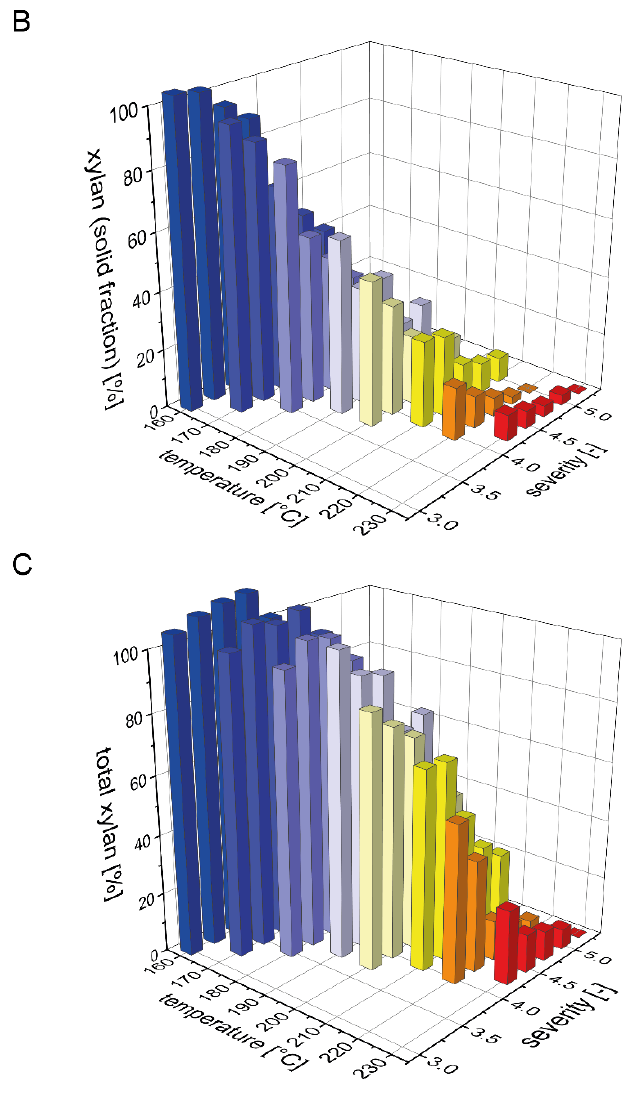
Figure 1. Mass balance for xylan after pretreatment. The recovery of xylan ( A ) in the prehydrolyzate in the form of xylose and soluble xylooligomers and ( B ) in the solids after steam explosion pretreatment. ( C ) The resulting total xylan recovery based on the composition of the raw material is shown as a function of pretreatment temperature and severity.